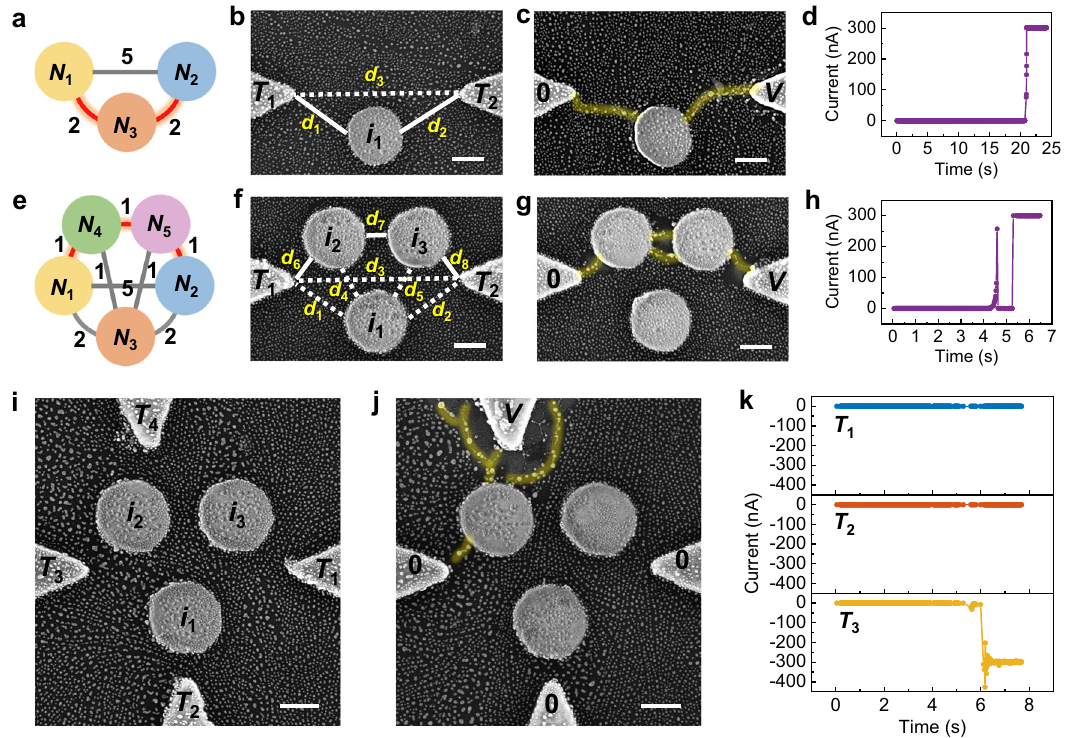
Fig. 3 | Application of integrated MAENs in the solution of graph problems. represent the nodes N 1 , N 2 , and the metal islands i 1 , i 2 , i 3 are used to represent the a Schematic illustration of a graph structure with one intermediate node N 3 intermediate nodes N 3 , N 4 and N 5 , respectively. The gap distance mapped with the weight of corresponding edges ( d 1 ↔ 2, d 2 ↔ 2, d 3 ↔ 5, d 4-8 ↔ 1). Scale bar: 200nm. between the nodes N 1 and N 2 . b SEM image of the device mapping with the graph g SEMimageofthe devicein f aftermemristiveswitching.Theconductive fi lament structure in a . The terminals T 1 , T 2 , and metal island i 1 are used to represent the nodes N 1 , N 2 , and N 3 , respectively. The gap distance mapped with the weight of isformedbetweentheterminals T 1 and T 2 bywayofthemetalislands i 2 and i 3 under corresponding edges ( d 1 ↔ 2, d 2 ↔ 2, d 3 ↔ 5).Scalebar:200nm. c SEMimage of the the applied voltage bias V (20V). Scale bar: 200nm. h I – t curve corresponding to theexperimentin g . i SEMimageofthedevicewithfourterminals( T 1 , T 2 , T 3 ,and T 4 ) device in b after memristive switching. Ag clusters self-organize into a conductive T i fi lament connecting the terminals T andthreemetalislands( i 1 , i 2 ,and i 3 ).Scalebar:200nm. j SEMimageofthedevicein 1 and 2 by way of the metal island 1 under the i after electrical stimulation. The conductive fi lament establishes the connection applied voltage bias V (25V). Scale bar: 200nm. d I – t curve corresponding to the experiment in c . e Schematic illustration of a graph structure with three inter- between T 3 and T 4 by way of i 2 . The applied voltage V was 15V. Scale bar: 200nm. k I – t curves of terminals T 1 (blue color), T 2 (orange color), and T 3 (yellow color) mediate nodes N 3 , N 4 , and N 5 between the nodes N 1 and N 2 . f SEM image of the device mapping with the graph structure in e . The terminals T 1 , T 2 are used to correspond to the experiment in j